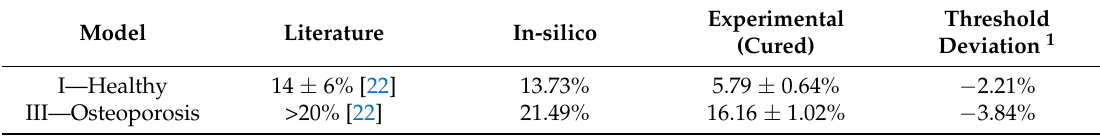
Table 4. Overall porosity for in-silico and experimental cortical bone